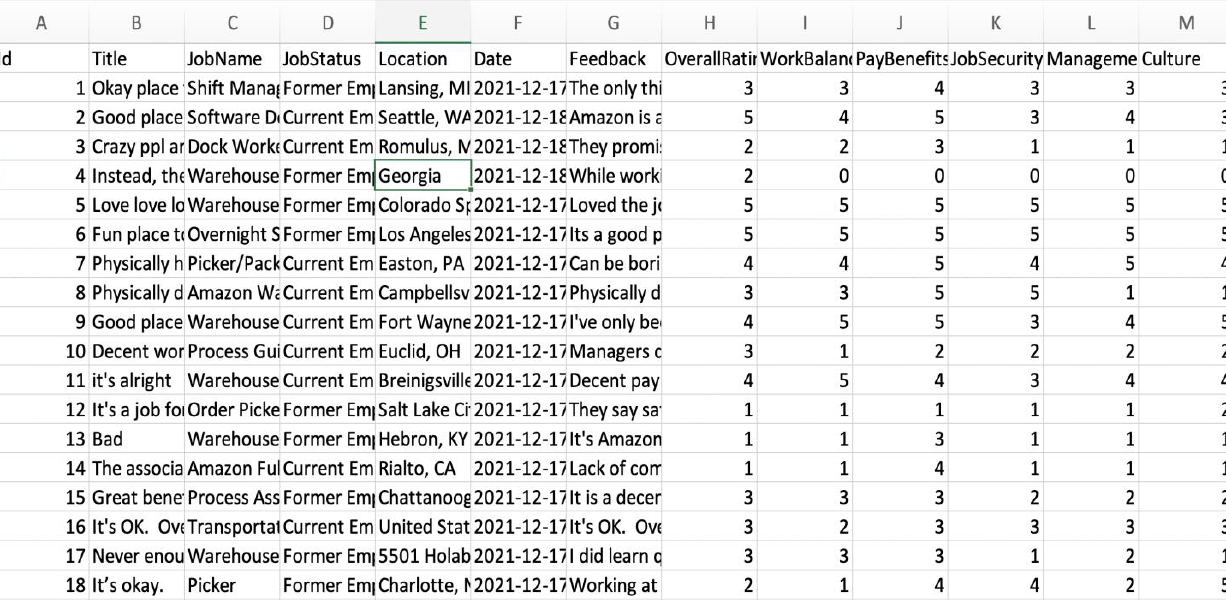
Figure 7. Overview of the final dataset.